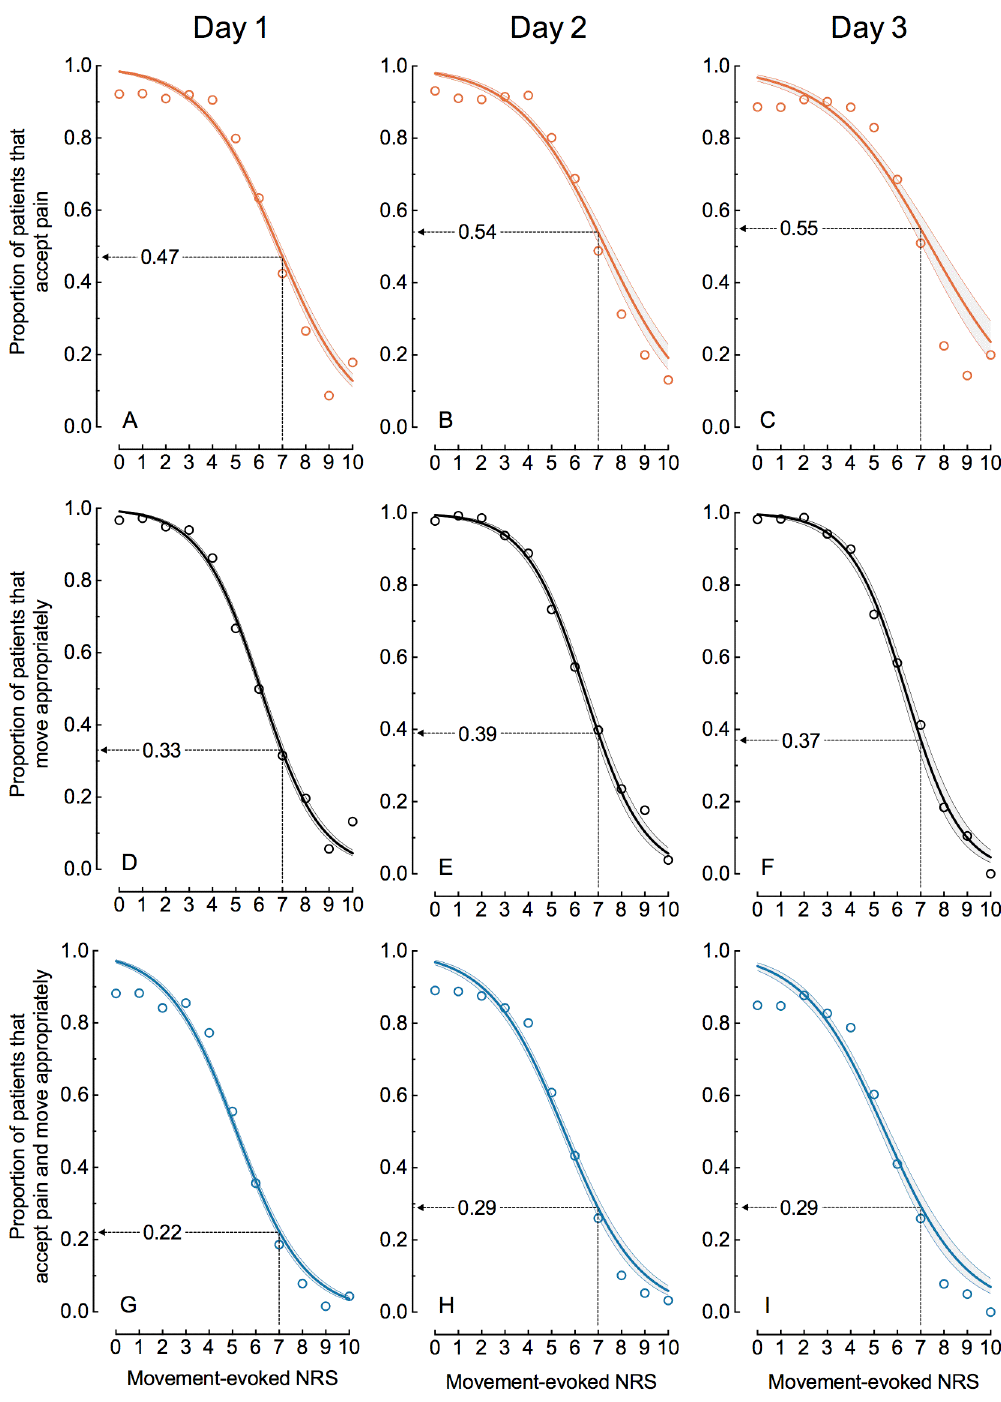
Fig 3. Estimated proportion (solid curve with its 95% confidence band) of patients that accept the pain (A-C), move appropriately (D-F) or accept the pain and move appropriately (G-I) as a function of NRS-MEP for day 1, 2 and 3 after surgery. The open circles represent the observedproportions of patients at each of the elevenpoints of the NRS. For each of the nine data sets, one estimated proportionis computed and shown at NRS-MEP =